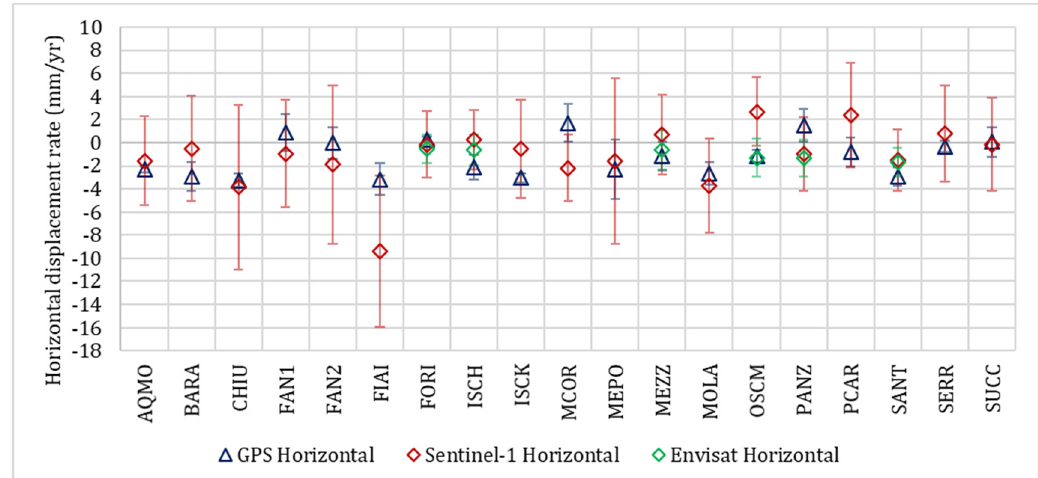
Figure 9. Comparison between GPS horizontal displacement rates (blue triangles) and those retrieved through SBAS processing using Sentinel-1A data (red diamonds) and Envisat data (green diamonds).